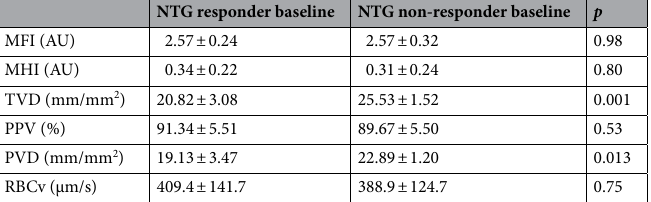
Table 5. Baseline microcirculatory function in NTG responders and